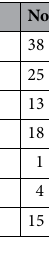
Table 2. Counts of lake Niphargus and olm co-occurrences by Niphargus species. Only co-occurrences in the exact same cave or spring are included.